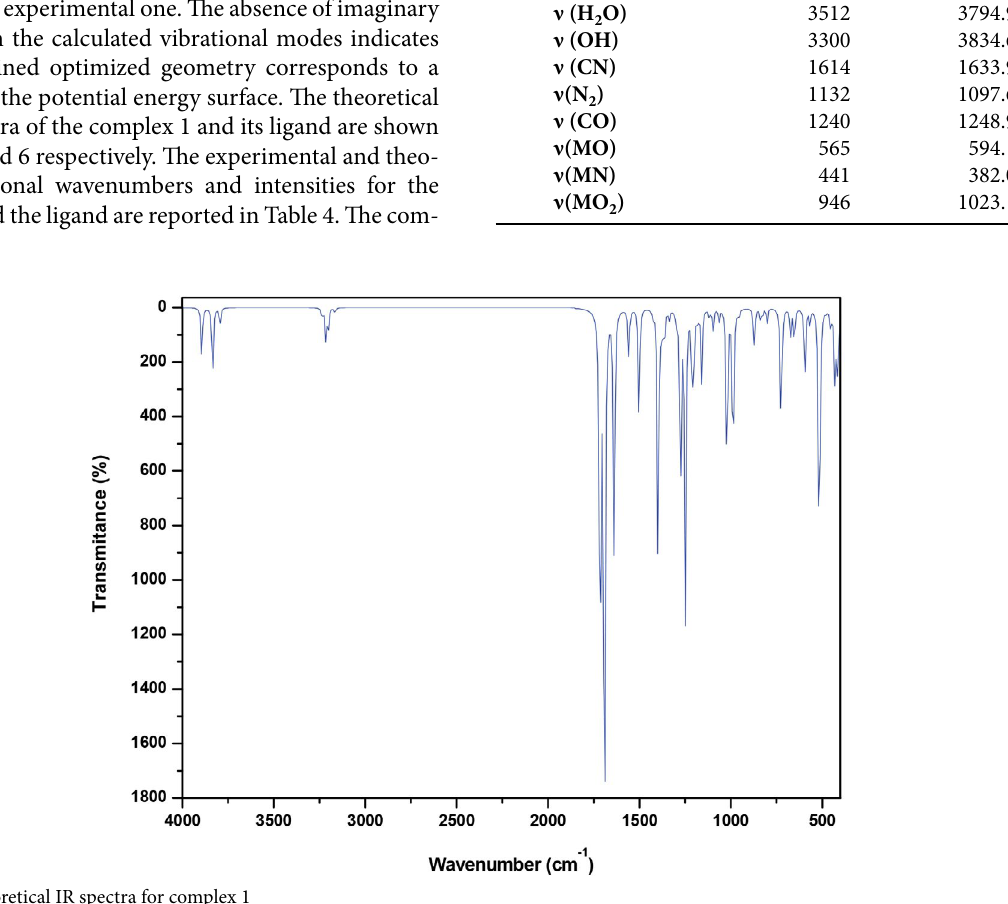
Figure 5. Theoretical IR spectra for complex